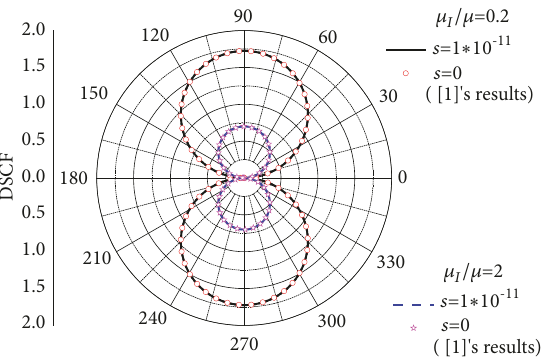
Figure 2: Comparison of the present and [1]’s results for the DSCF.